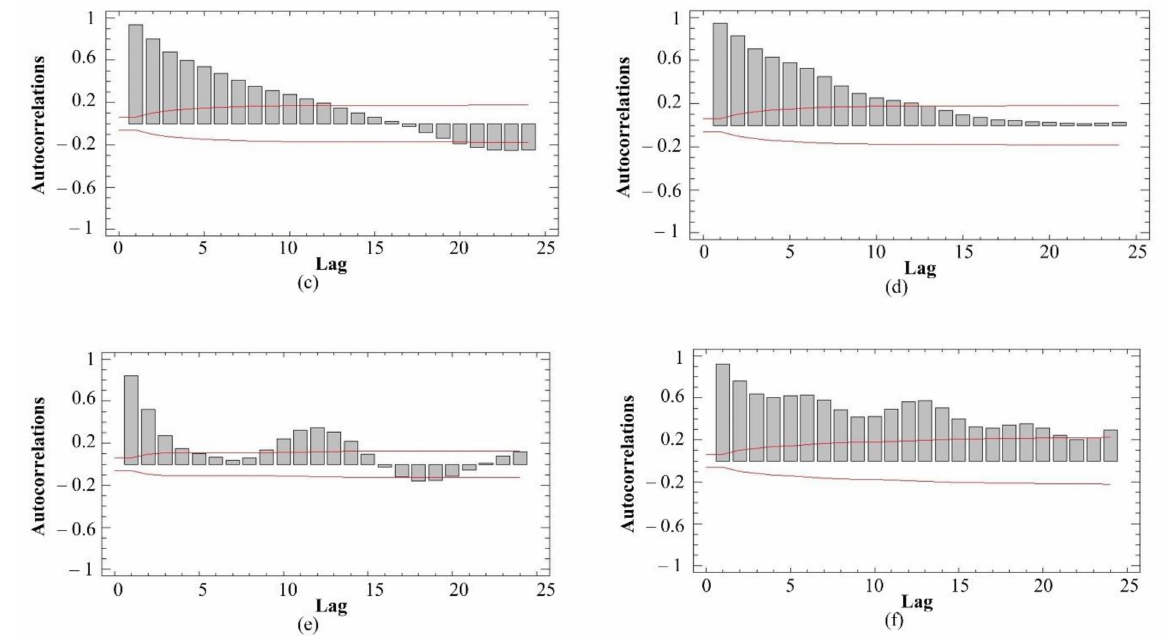
Figure 7. The drawbar pull signal autocorrelations: ( a ) standard tires (low load); ( b ) standard tires (high load); ( c ) spike tires (low load); ( d ) spike tires (high load); ( e ) blade wheels (low load); ( f ) blade wheels (high load).